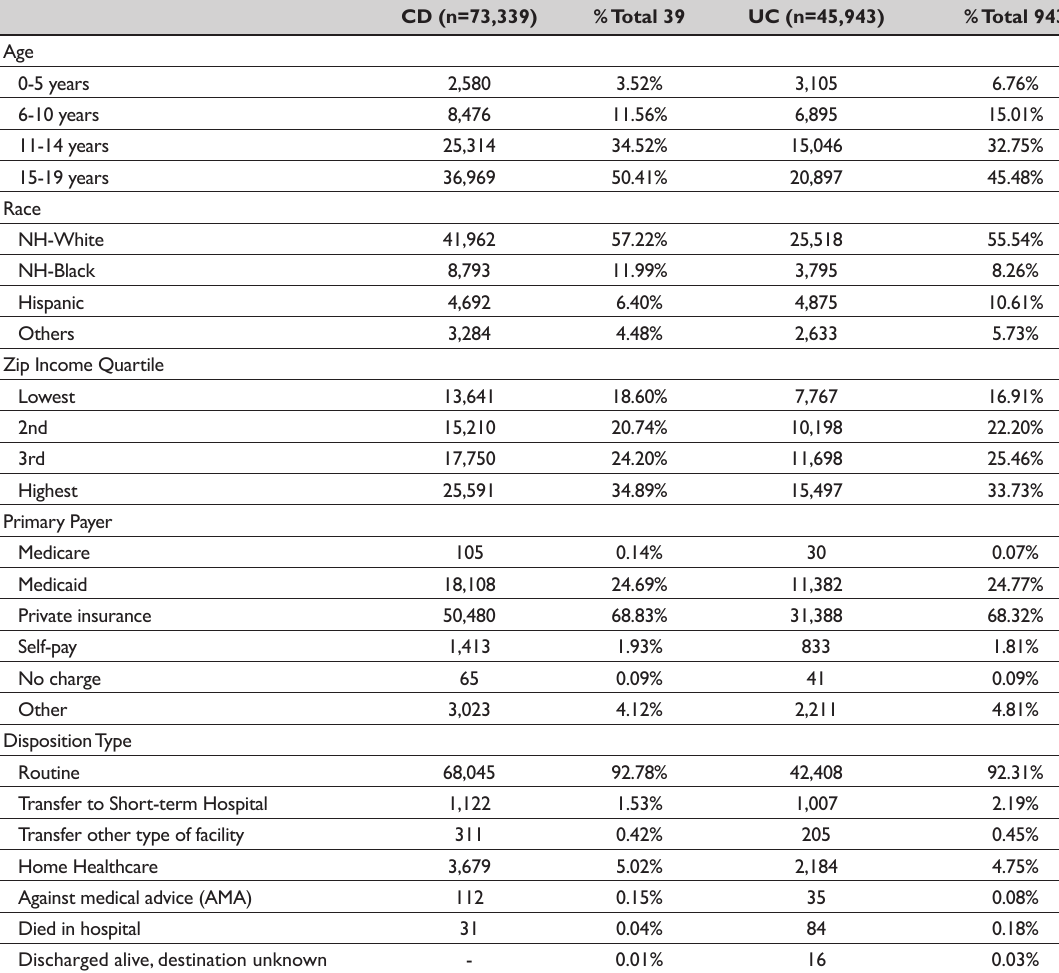
Table 1: Socio-demographic characteristics of children with Crohn’s disease (CD) and ulcerative colitis (UC) - principal and 2 nd